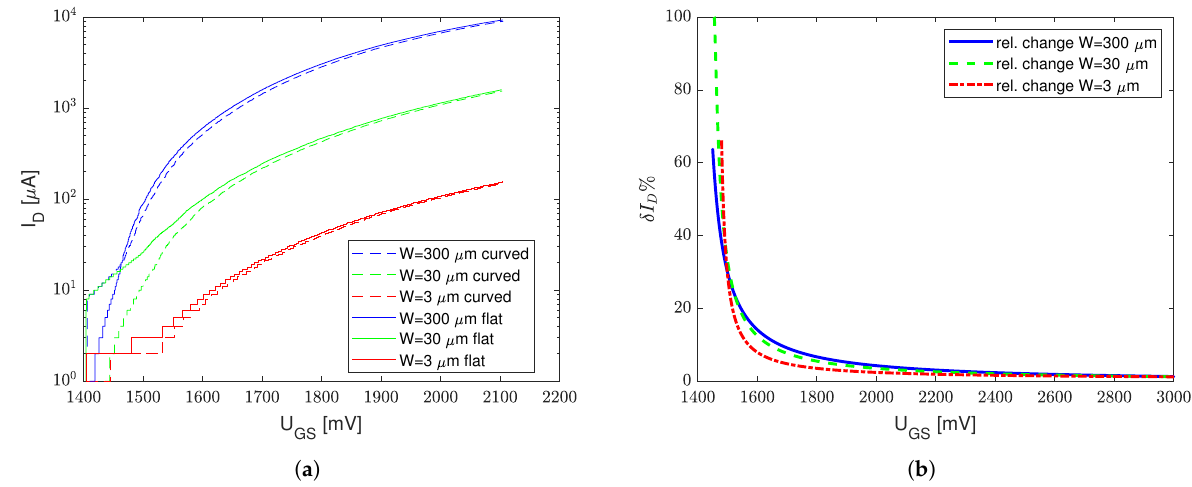
Figure 3. Transistor transfer characteristics for unstressed and stressed conditions (compressive strain (cid:15) = 0.2%). Transistors with the minimum channel length ( a ) and a relative difference of I D and I D transfer characteristics (with and without compressive strain) at various U GS ( b ).